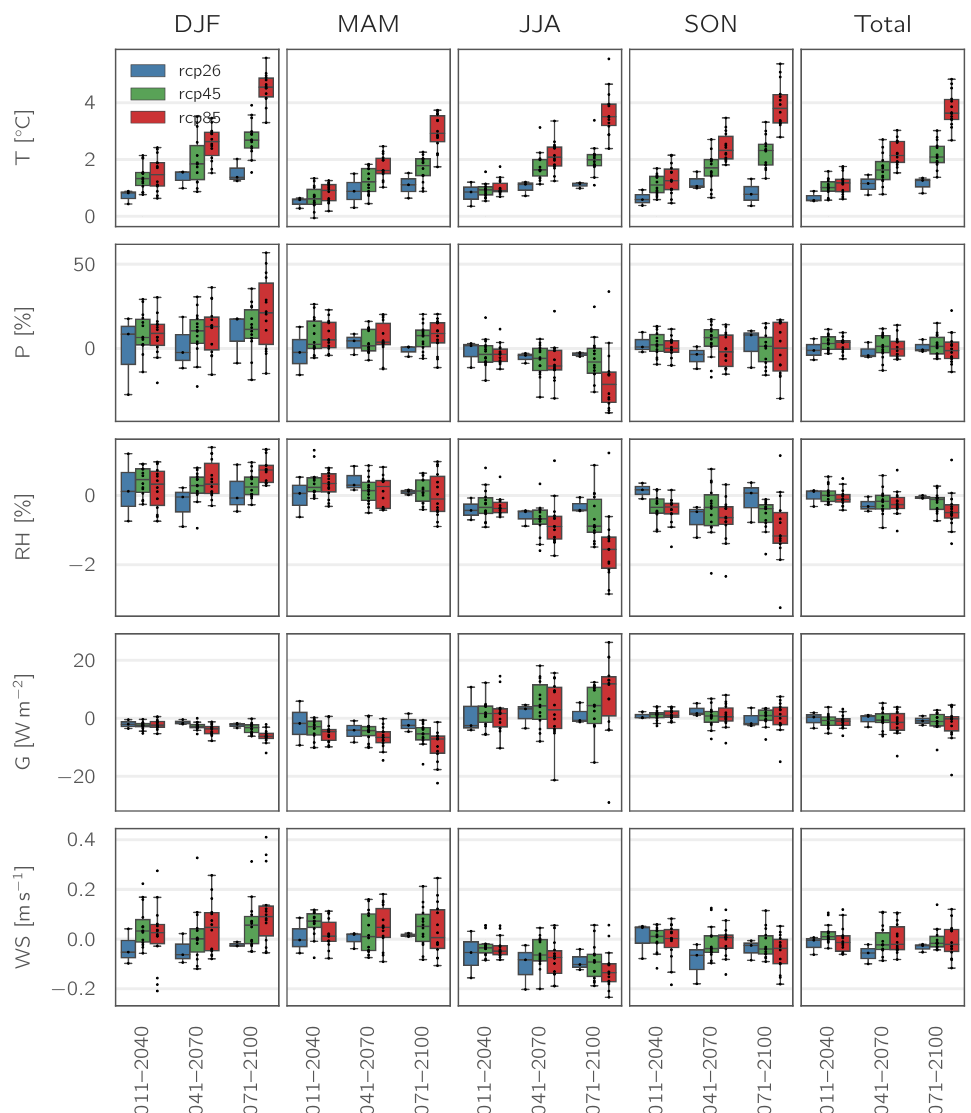
Figure 7. Projected seasonal changes for temperature ( T ), precipitation ( P ), relative humidity (RH), global radiation ( G ), and wind speed (WS) according to the selected EURO-CORDEX scenario simulations (spatial averages over the study area; changes calculated relative to 1971–2000). Small dots represent the individual GCM–RCM